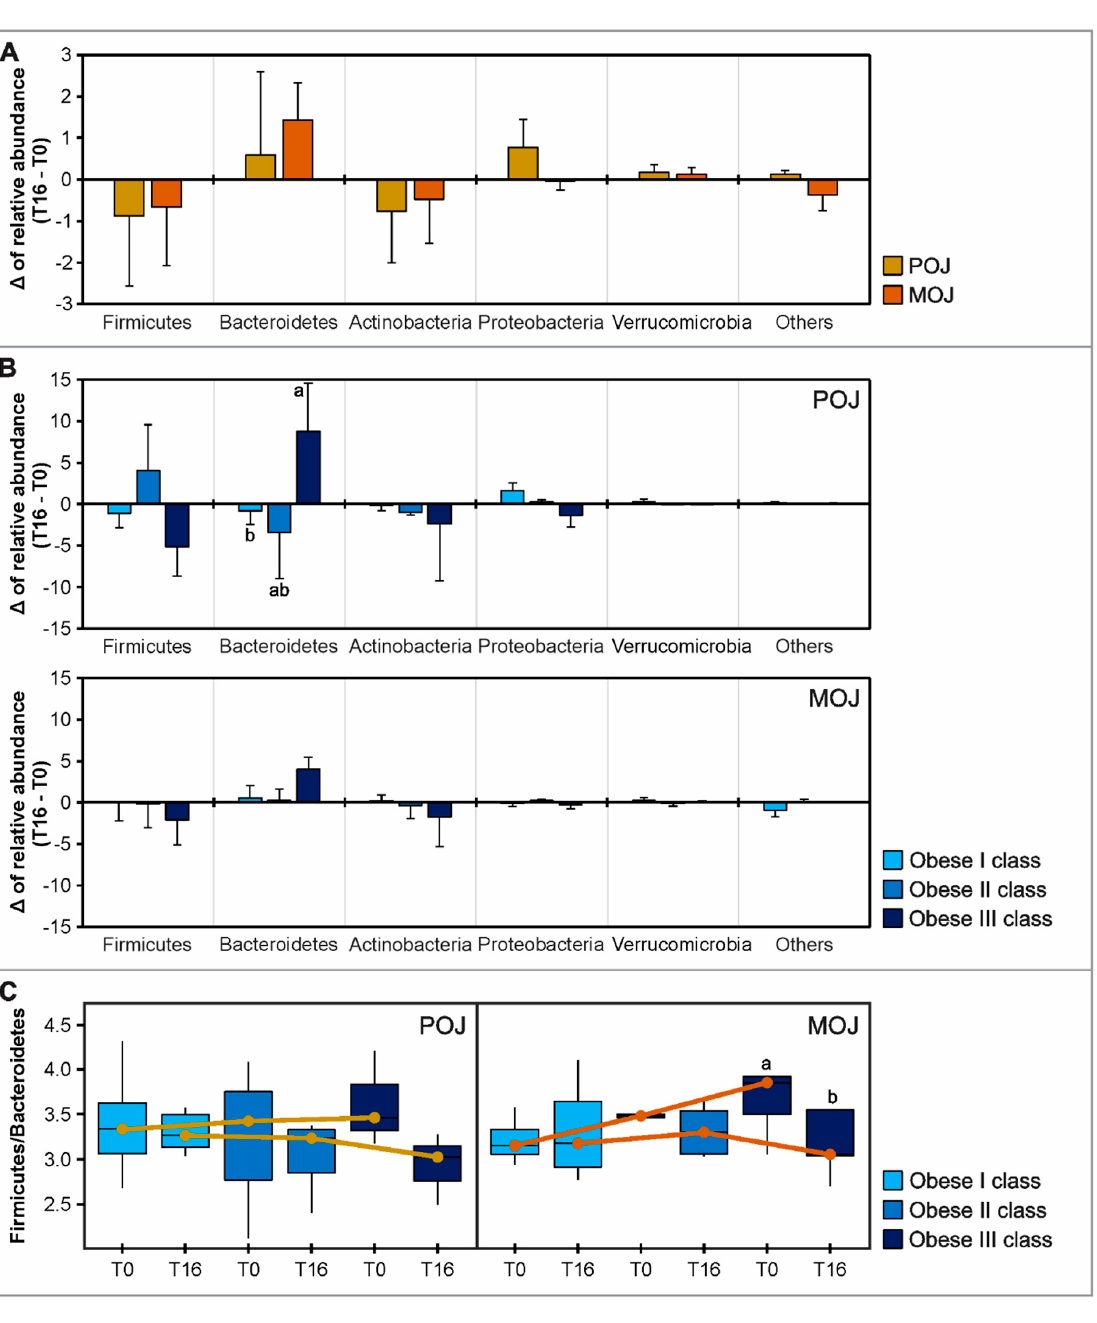
Figure 2. Effect of Pera (POJ) and Moro orange juice (MOJ) intake on the gut microbiota OTUs (phylum) and on the Firmicutes/Bacteroidetes (F/B) ratio. Delta of the relative abundance of the most abundant bacterial phyla when patients are grouped by ( A ) intervention and ( B ) obesity class. ( C ) Boxplot showing F/B ratio of the individuals in obesity classes I, II, or III before (T0) and after (T16) POJ and MOJ intake. For clarity, phyla with an overall abundance of less than 0.5% were summed into “others”. Different superscript letters indicate statistical significance ( p < 0.05) between obesity classes (Kruskal–Wallis test) or between T0 and T16 (Wilcoxon test) (sample sizes in POJ intervention: obesity class I, n = 9; obesity class II, n = 3; obesity class III, n = 3; sample sizes in MOJ intervention: obesity class I, n = 8; obesity class II, n = 5; obesity class III, n =